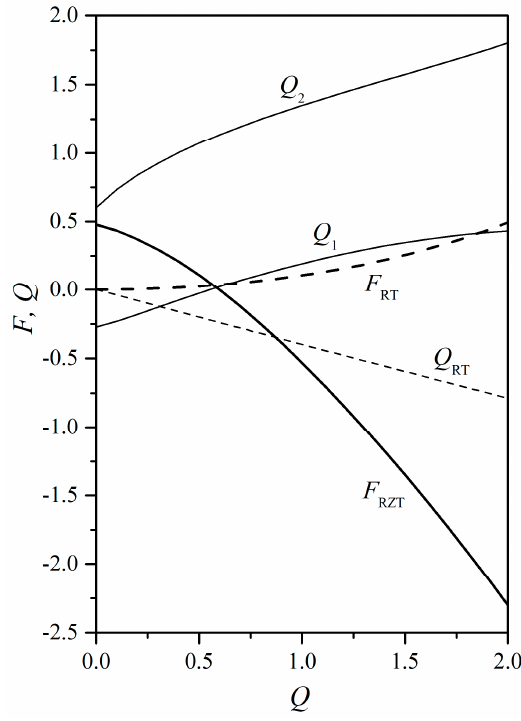
Figure 5. Dependence of the minimum energies (thick lines) and chirality parameters (thin lines) of the radially z-twisted (RZT) structure (solid lines) and radially twisted (RT) structure (dashed lines) on the intrinsic chirality Q . k 24 = 0.5, zenithal anchoring with w = 1.